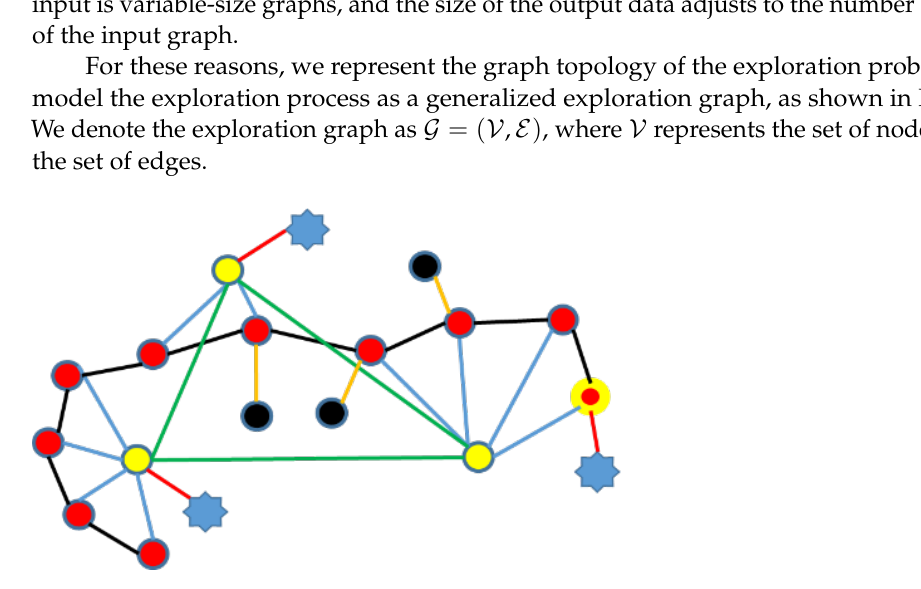
Figure 2. Extracting the exploration graph. The historical trajectories, frontier waypoints, landmarks, and obstacles are shown in red, blue, yellow, and black, respectively. The current position in trajectories is stressed with the yellow border , and the frontier waypoints are served as the candidate target